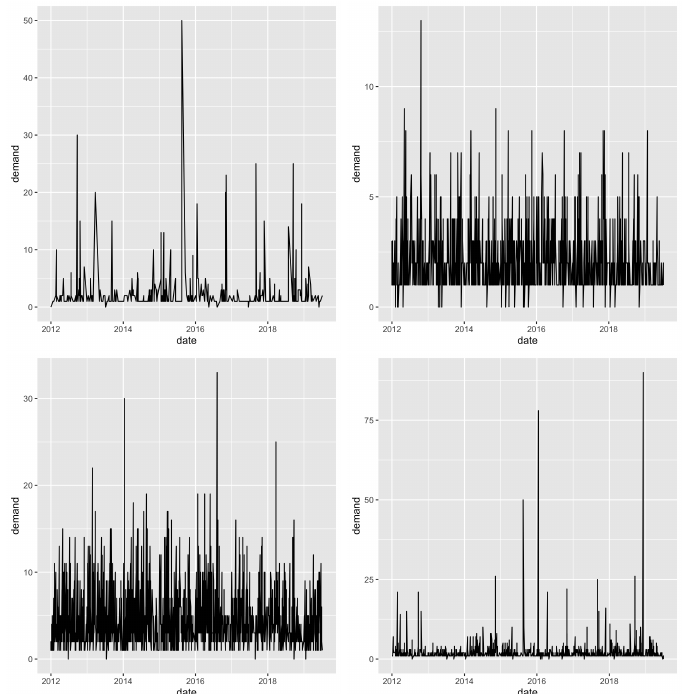
Figure 2. Examples of demand time series in the